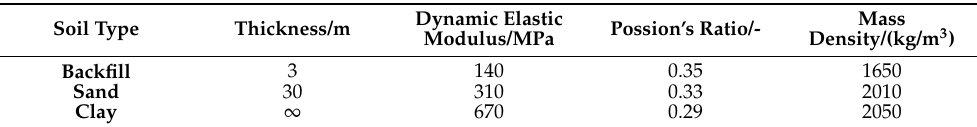
Figure 10. FE model of tunnel - soil . Table 2. Soil parameters .